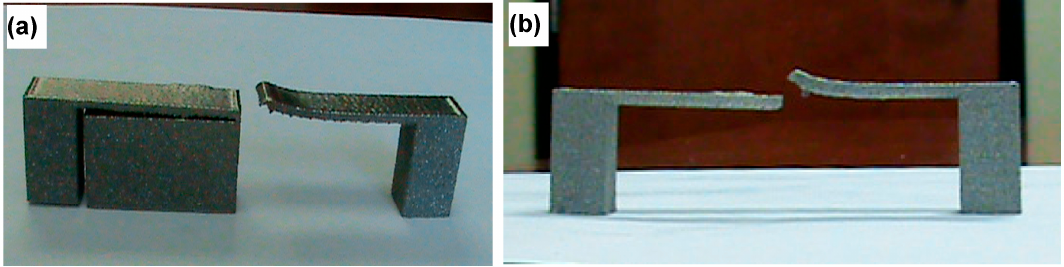
Figure 15. Fabricated long overhang parts: ( a ) Isometric view comparison, and ( b ) side view comparison. In both, Left: with minimum-contact heat support, and Right: without support.